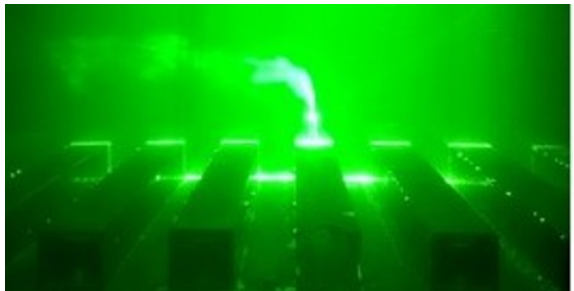
Fig. 5. An example of tracer emission from the chimneystack.